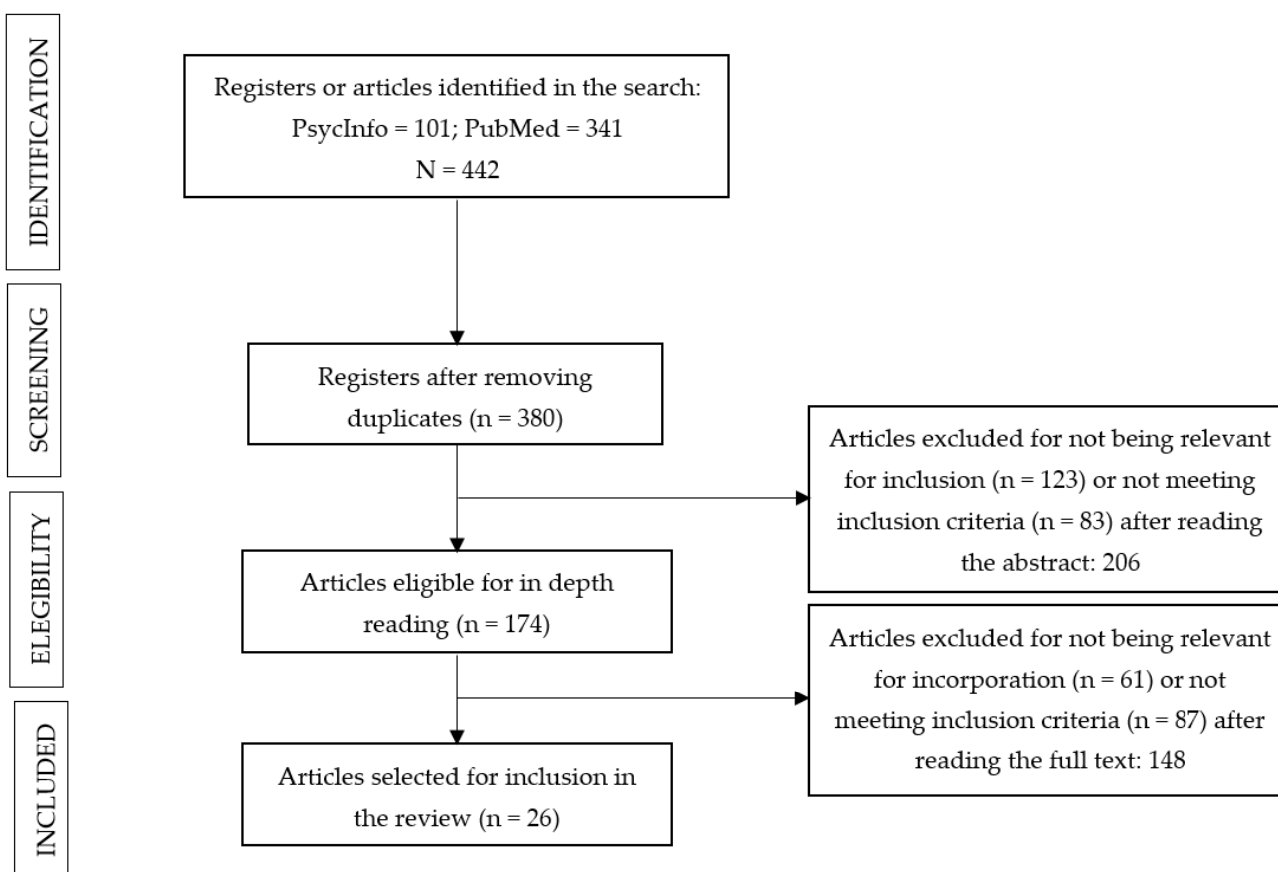
Figure 1. Article selection process.